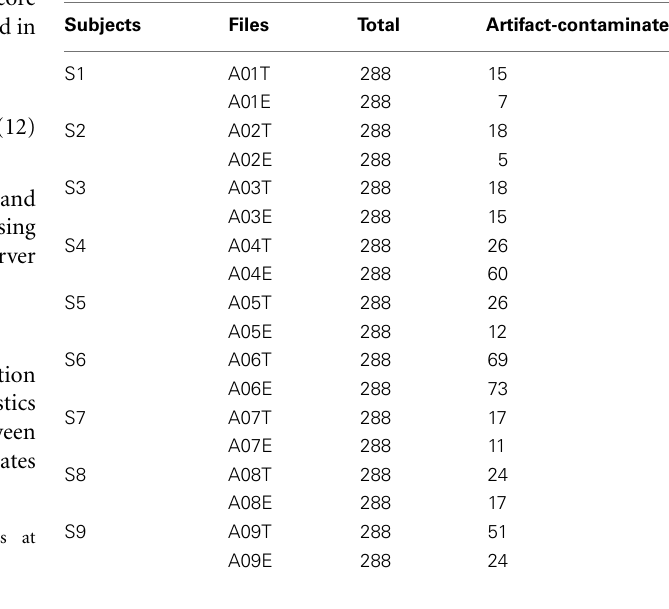
Table 1 | Summary of the number of artifact-contaminated trials for each